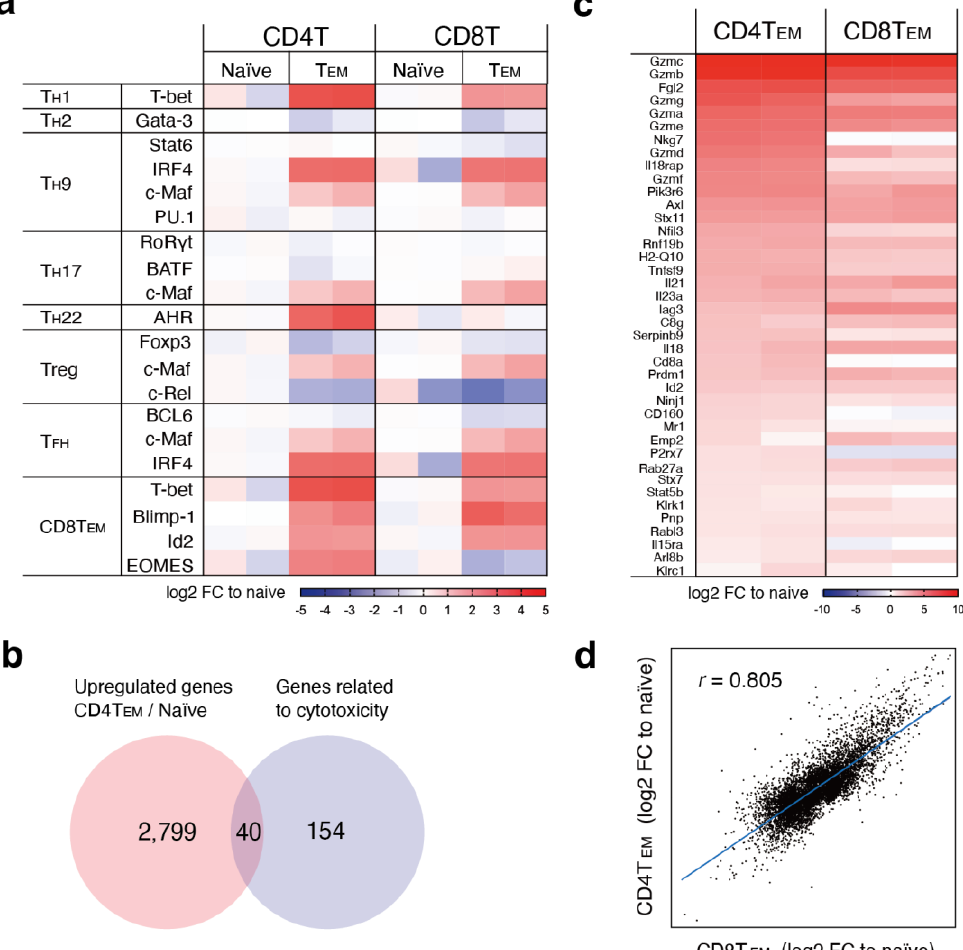
Figure 3. Characterization of LMP1/2A + B lymphoma cell-specific T cells. Both CD4 + T EM cells and CD8 + T EM cells were purified on day 25 of in vitro cell culture with iCL and analyzed for RNA expression by microarray. Expression values are normalized, and log2 fold-change (FC) values are calculated to each naïve T cell (n = 2). ( a ) Expression pattern of master regulators of various T cell subset differentiation programs. ( b ) The Venn diagram depicts the number of genes upregulated in CD4 + T EM cells compared to naïve CD4 + T cells and the number of genes associated with cytotoxicity based on GO terms. ( c ) The heat map shows log2 FC values of 40 genes overlapped in ( b ). ( d ) The scatter plot shows the mean log2 FC values of global gene expression in CD4 + T EM cells (y-axis) and CD8⁺ T EM cells (x-axis) compared to naïve T cells. The correlation coefficient is shown.